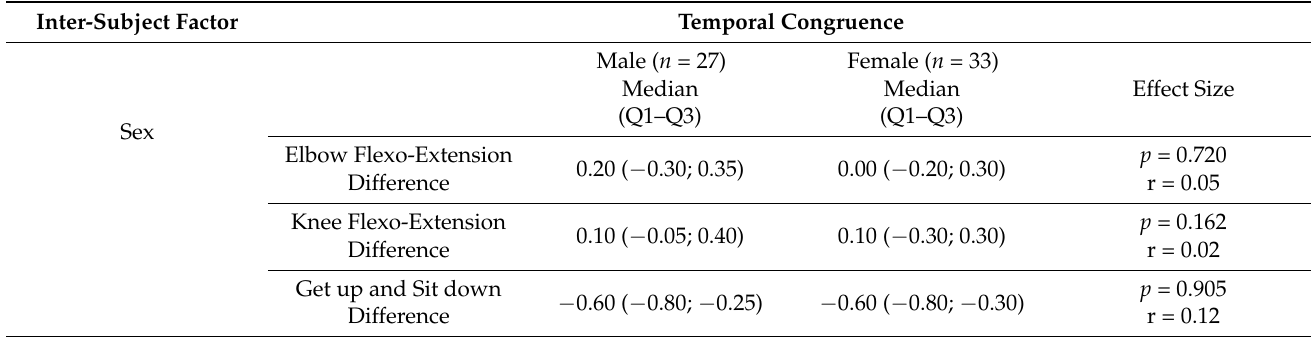
Table 6. Temporal congruency concerning